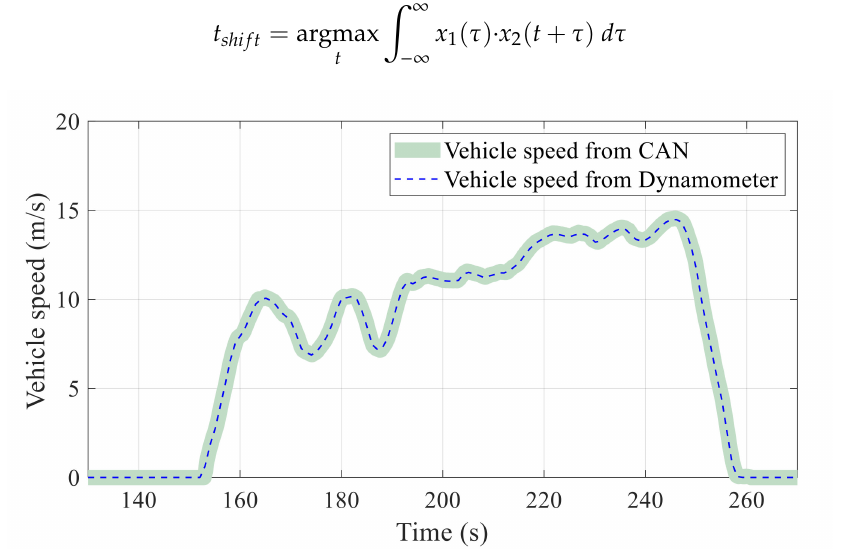
Figure 5. Signal Alignment of Vehicle Speed